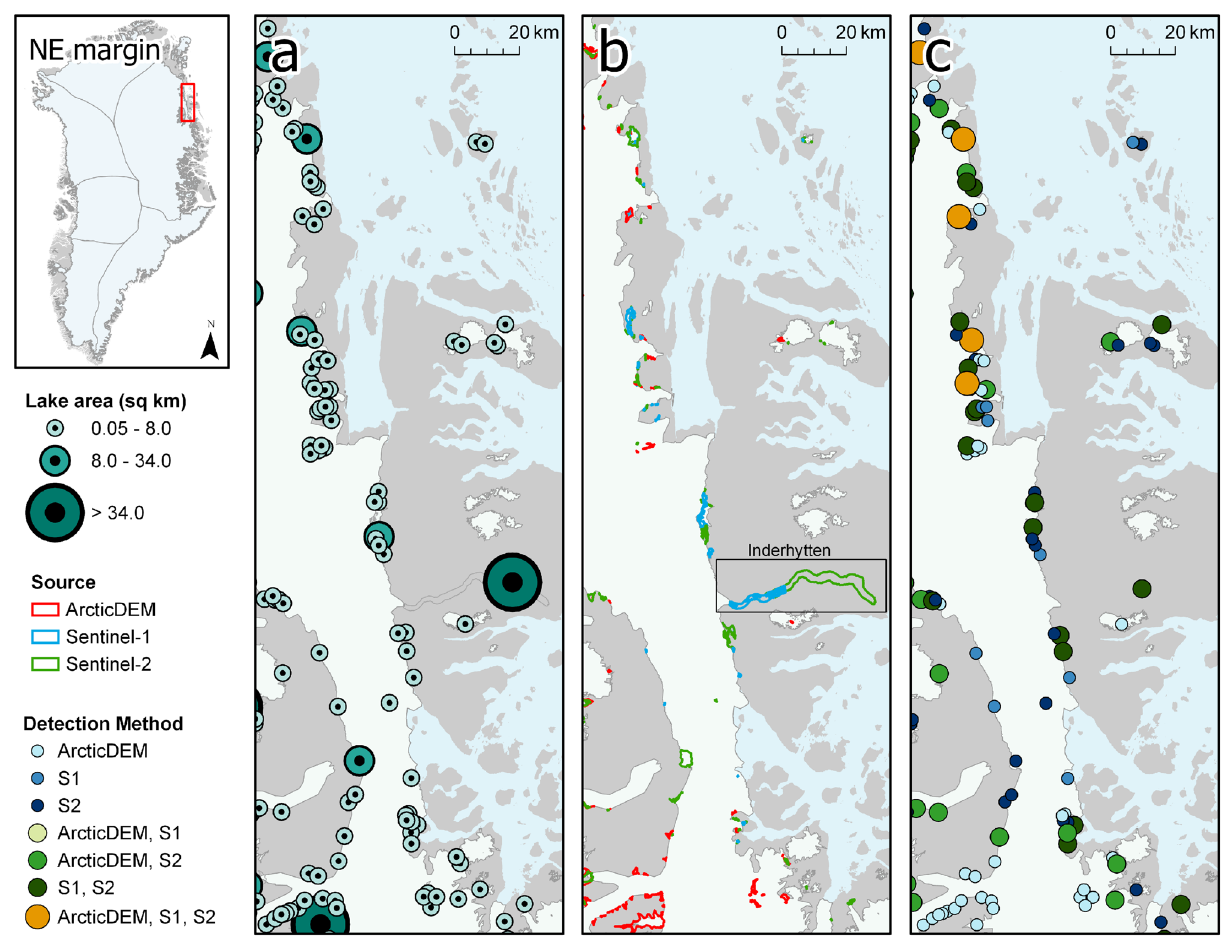
Figure 3. Ice marginal lakes over a selected section of the NE ice sheet margin, where ( a ) lake area, ( b ) lake shape determined by each method (as described in the “Methods” section), and ( c ) detection method are presented, including the second largest lake of the IIML, Inderhytten (black box). Ice, land and ocean are displayed in white, grey and light blue, respectively. The ice margin shown is a modified version of the MEaSUREs GIMP ice mask 33 . Figure generated with ArcGIS Pro (v2.6.1, https ://www.esri.com/en-us/arcgi s/ produ cts/arcgi s-pro/) 66